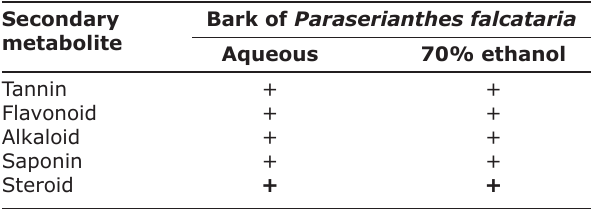
Table-1: Qualitative phytochemical